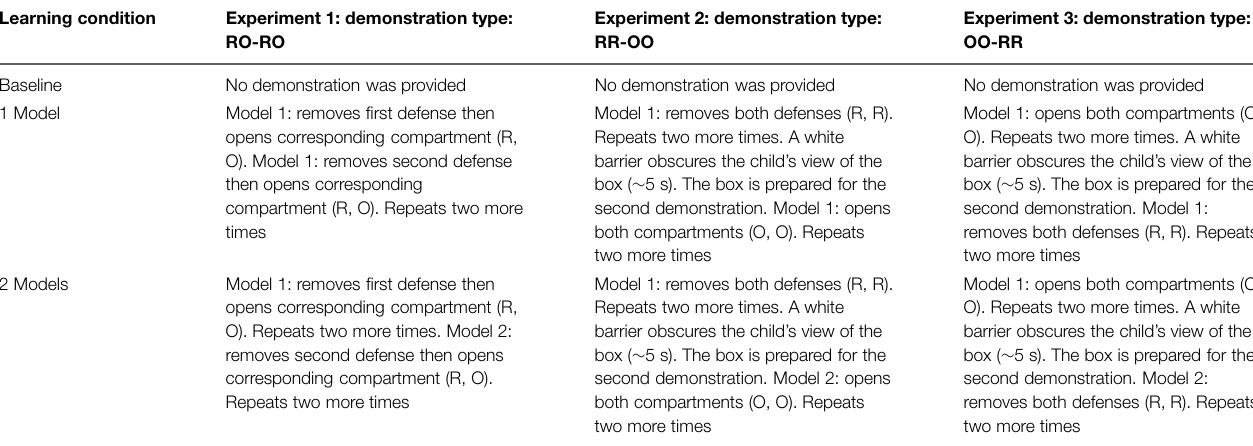
TABLE 1 | Summary of learning